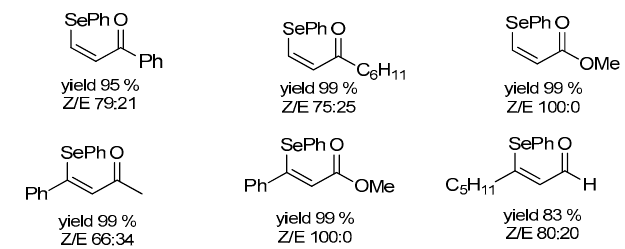
Figure 9. Vinyl selenide prepared by conjugated addition of PhSeZnCl to propargylic derivatives in